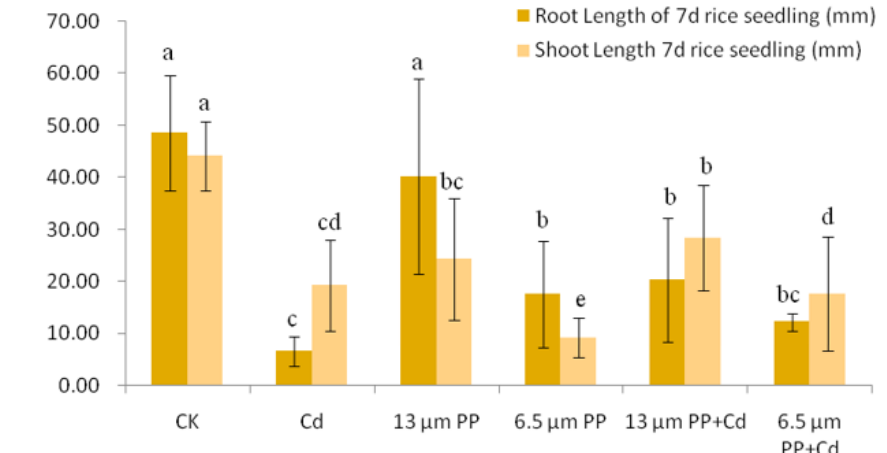
Figure 2. Effect of single and combined treatment of PP-MP and Cd on root and stem length of 7-day rice seedlings. Results are shown in mean ± SD ( n = 9). Different letters a, b, c, d represent significant difference between different treatments groups at the same MP particle size or at same cadmium concentration (at p ≤ 0.05), whereas the same letters indicate insignificant differences between treatments. Where CK—Control check; Cd—Cadmium; PP—Polypropylene.